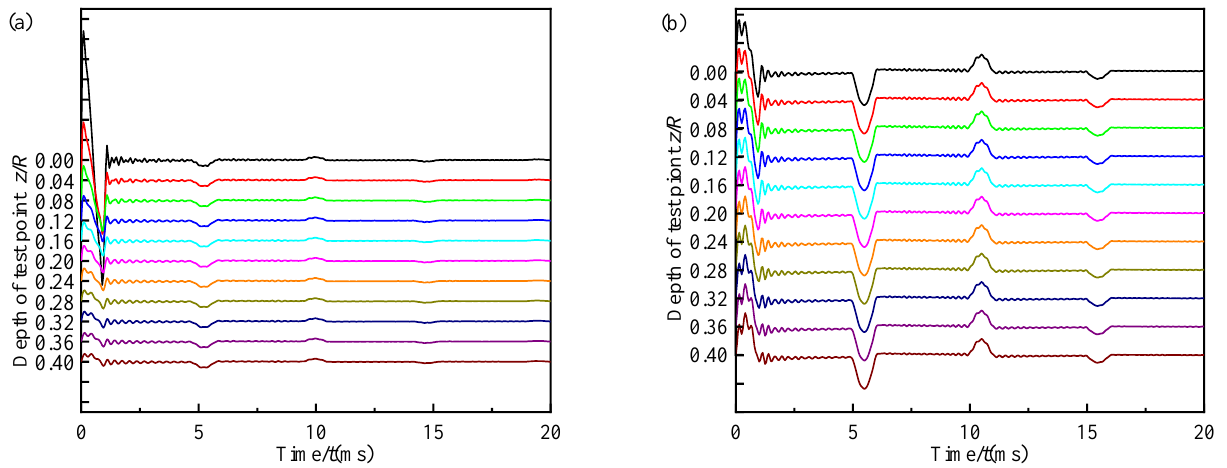
Figure 14. Vertical velocity time domain curves at different test points along the depth of pile: ( a ) r = r h ; ( b ) r = 0.2 R h